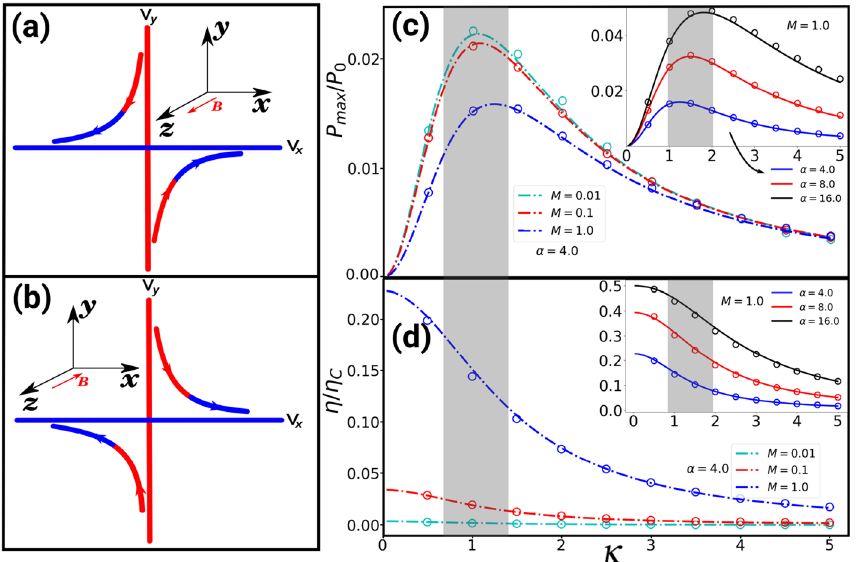
Figure 3. ( a ) and ( b ) show the schematics of the heat transfer in the velocity space due to an external magnetic field in the z and − z directions, respectively. The velocity component which is coupled to the hot heat bath picks up higher kinetic energy, which due to the Lorentz force, gets transferred to the velocity component which is coupled to the cold heat bath on the time scale m /γ . This results in a heat transfer from the hot to the cold bath, shown in red and blue, respectively, in the velocity space. In ( c ), we represent the scaled maximum power with respect to the diffusive Hall parameter for α = 4.0 , T h = 4 T c = 4.0 , and different values of M where M = km /γ 2 and P 0 = ( T c + T h )/γ . In ( d ) we show the scaled efficiency η/η c corresponding to scaled maximum power in ( c ). While the maximum power decreases with increasing M , the corresponding efficiency increases due to the reduction in heat loss in the velocity space. The insets of ( c ) and ( d ) depict the scaled maximum power and the scaled efficiency for M = 1.0 and different values of α , respectively. The maximum power and corresponding efficiency increases with increasing α . The shaded regions in ( c ) and ( d ) mark the κ region in which the magneto-gyrator is operating close to maximum power and the corresponding efficiency. The lines show the theoretical predictions and the symbols are simulation